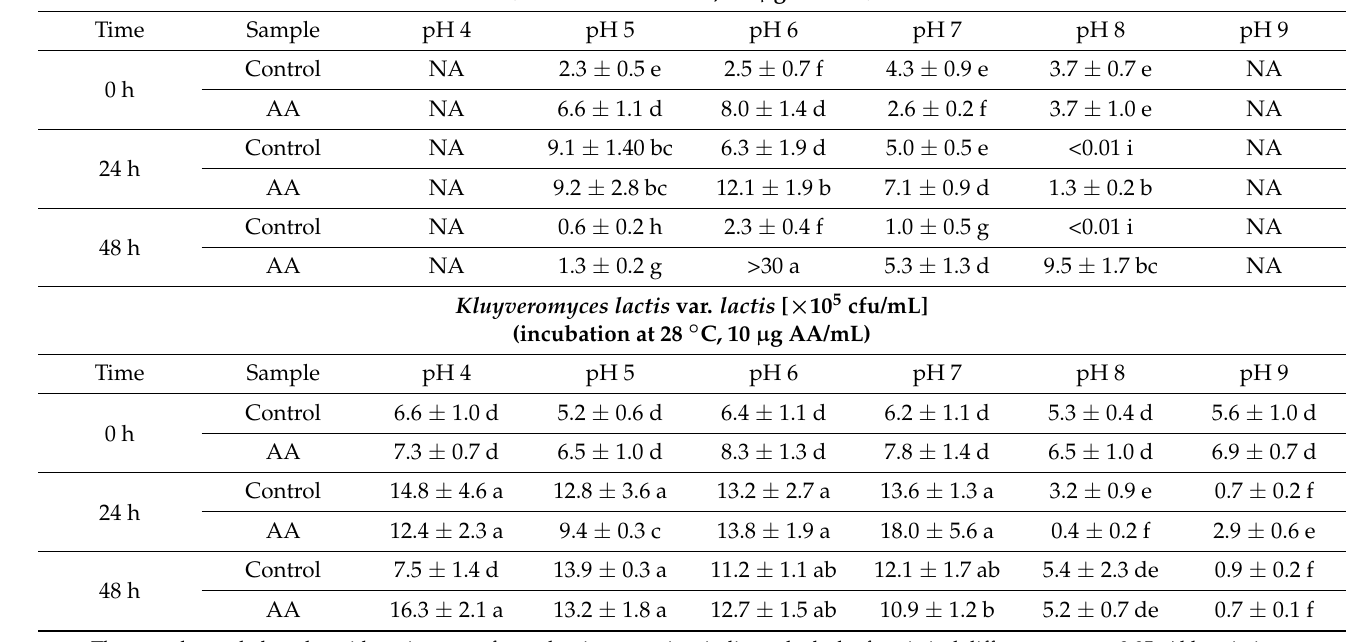
The same letters below the arithmetic means for each microorganism indicate the lack of statistical differences at p < 0.05. Abbreviations: AA, acrylamide present in MRD medium at concentration of 10 µ g/mL (yeast) or 7.5 µ g/mL (bacteria); Control, control sample prepared by adding 1 mL of microbial suspension to 9 mL of AA-free MRD adjusted to adequate pH; NA, not